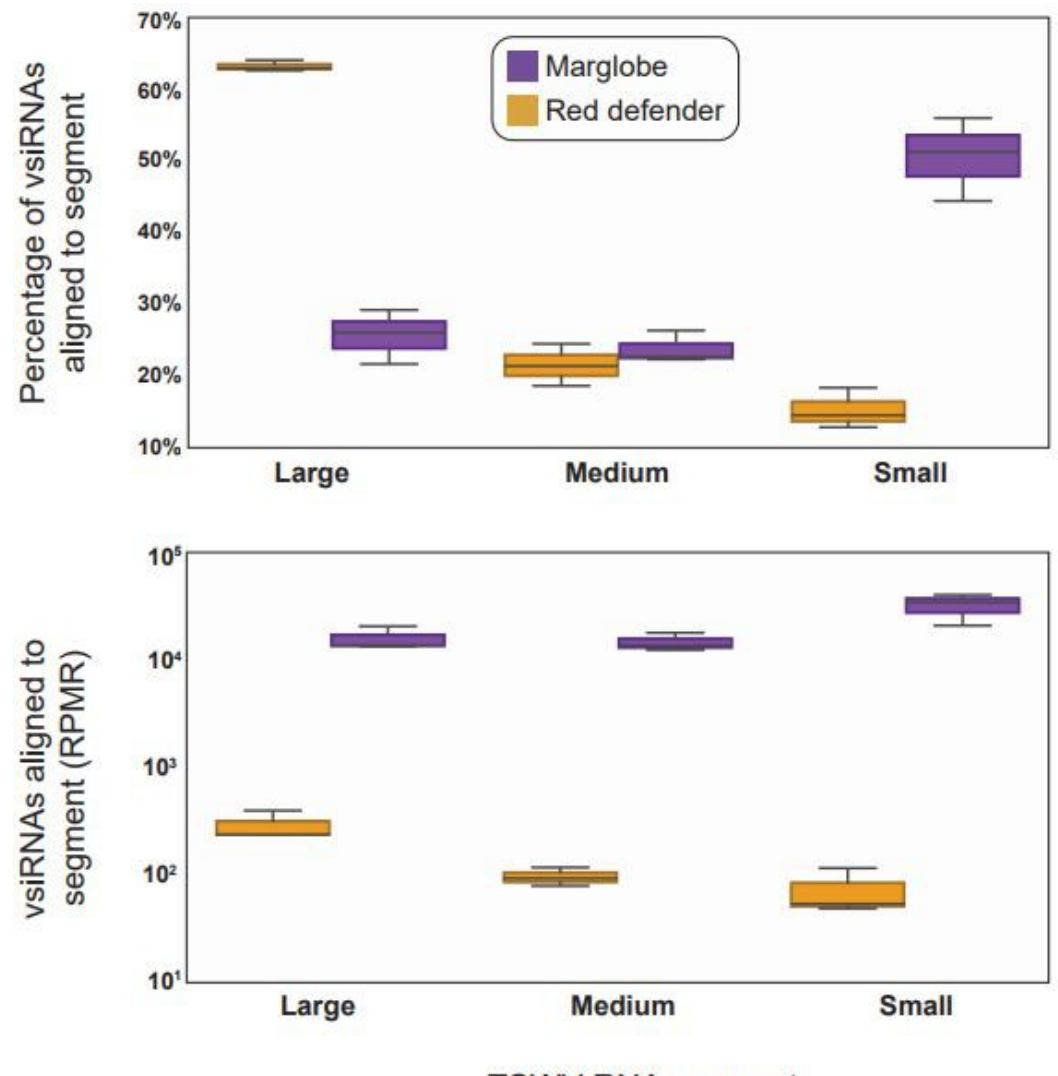
Figure 4. Boxplots of the viral-derived small interfering RNAs matching the segments of tomato spotted wilt virus (TSWV). Upper diagram corresponds to the percentage of vsiRNAs matching the Large, Medium, and Small RNAs. Bottom diagram corresponds to the reads-per-million-reads (RPMR) matching the three TSWV RNAs. Each plot corresponds to the average of three biological replicates with standard error bars. Purple corresponds to tomato cv. Marglobe, the susceptible genotype Sw -5( − ), while the yellow line corresponds to cv. Red Defender, the resistant genotype, Sw -5( + ). ANOVA analysis followed by Tuckey Honest Significant Di ff erence (HSD) test ( p -value <0.05).